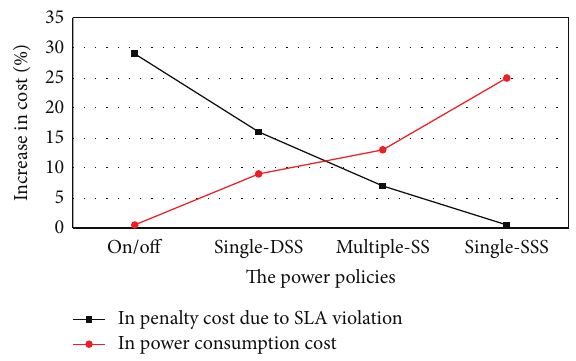
Figure 10: The trade-off between power and performance with different power management